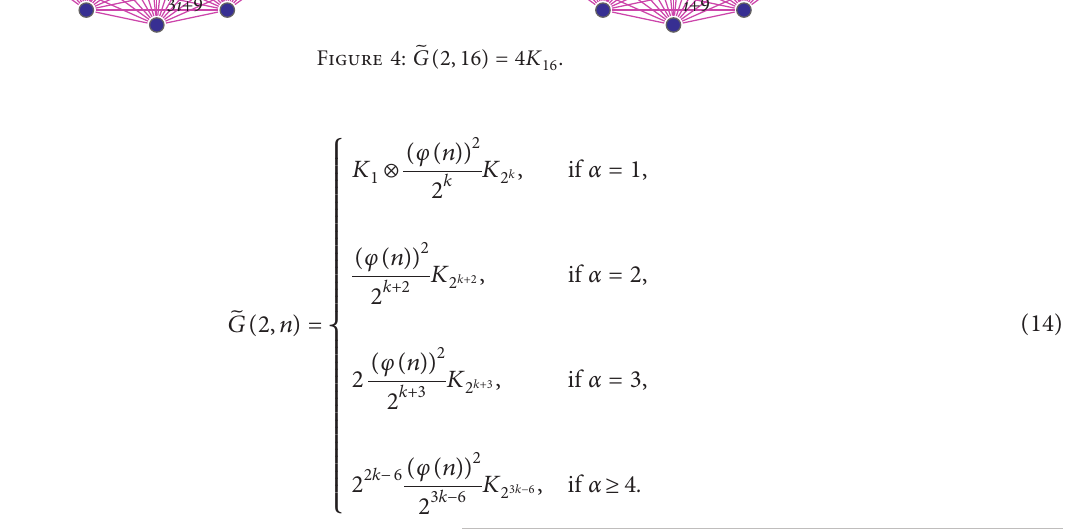
Figure 4: 􏽥 G ( 2 , 16 ) � 4 K